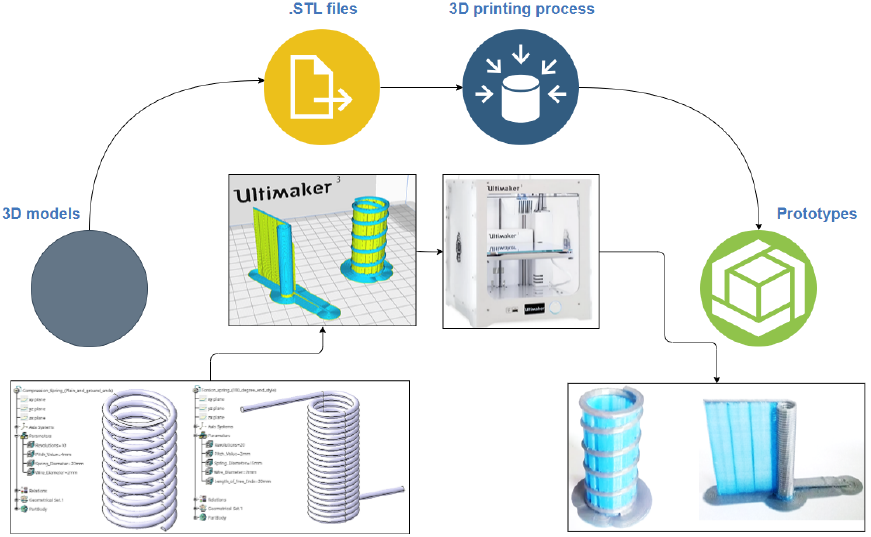
Figure 9. Schematic representation of a spring prototyping procedure (features implemented through Springs IICAD system).